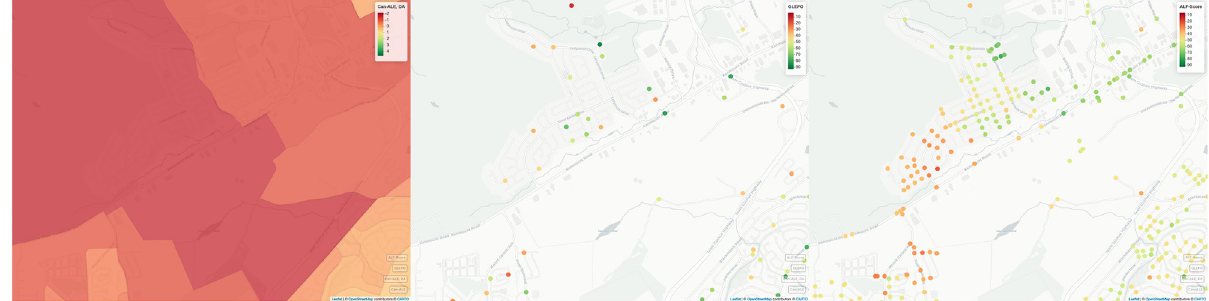
Fig 5. Comparison between GLEPO, ALF–Score and Can–ALE for Great Eastern Ave. in St. John’s, NL. Left: Can–ALE, Center: GLEPO, Right: ALF–Score. A score variation ranging between 16–81 is observed within GLEPO which provides a user–level insight about how users actually perceive their neighbourhood in their own opinion, as opposed to what Can–ALE suggests of a neighbourhood to its users. Furthermore, we can observe a variation ranging between 20–70 in ALF–Score which provides a high spatial resolution rankings that are well refined and specific to each point as opposed to a single score for an entire area as observed in Can–ALE. Note: Can–ALE colors are slightly dimmed due to the adjusted opacity/ transparency to better visualize the street overlay. (Maps generated through RStudio [31] Version 1.2 using mapview package from rstudio.com with OpenStreetMap used as its base map).